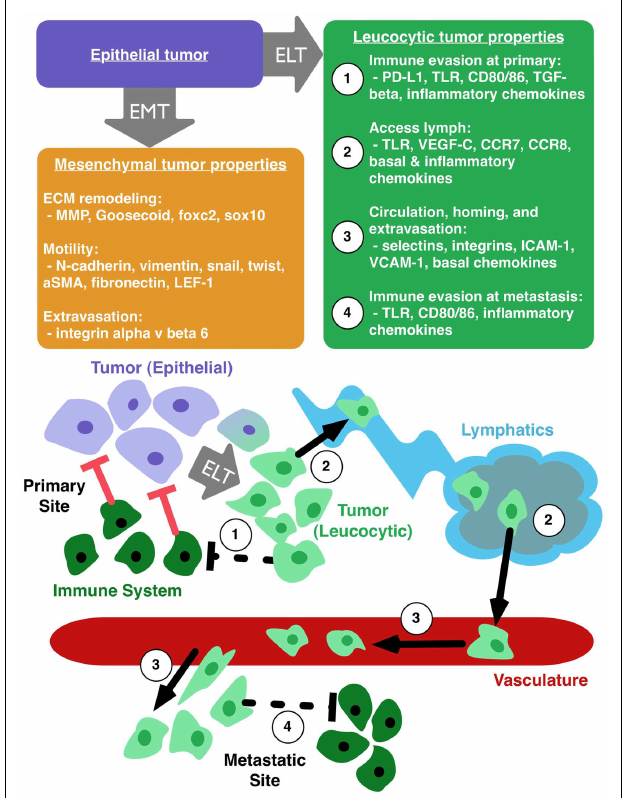
FIGURE 1 | Epithelial to leucocytic transition (ELT) is the acquisition of immune properties by tumor cells . Epithelial tumor cells (purple box) can make transition to a mesenchymal phenotype (orange box), which enhances local motility and remodeling of the extracellular matrix (ECM). Tumor cells undergoing ELT (green box) can gain the ability to (1) evade the immune system at the primary tumor site, (2) access the lymphatic system, (3) circulate through the vasculature, home to favorable sites of metastasis, and extravasate into a metastatic niche, and (4) avoid destruction by the immune system at the site of